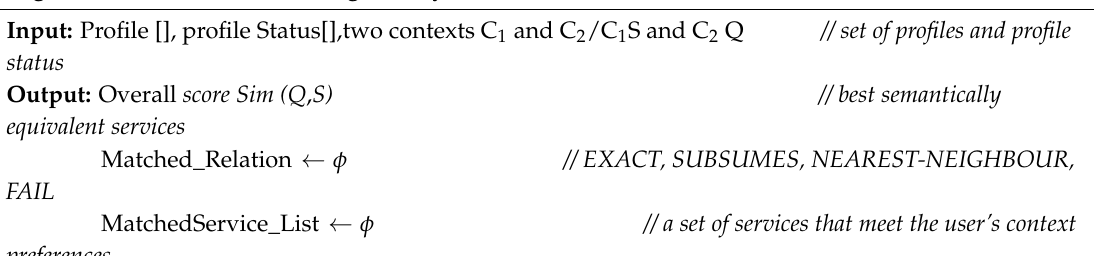
Algorithm 1: Situation Matching and Dynamic Service